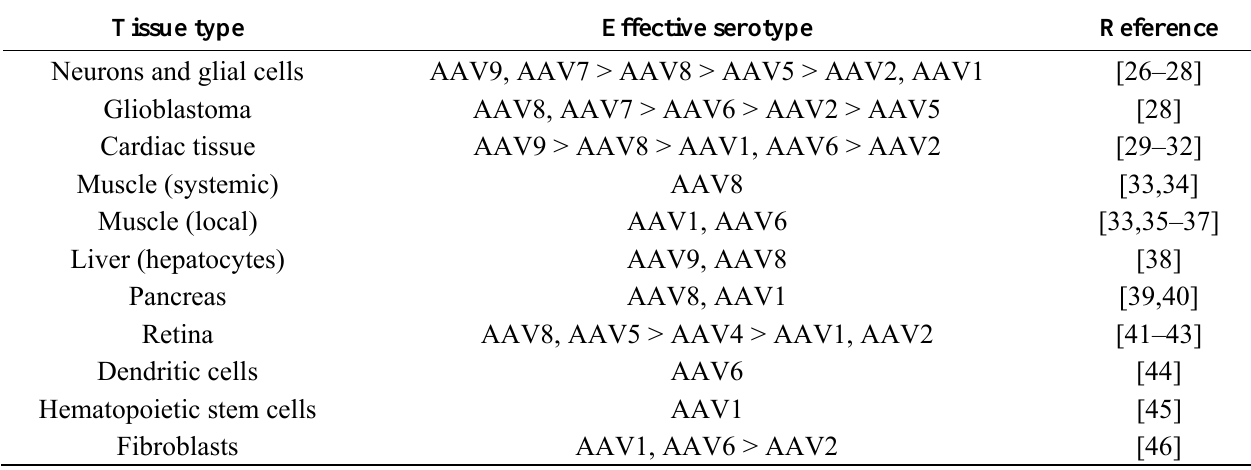
Table 1. Transduction efficiencies or representative rAAV serotypes in major